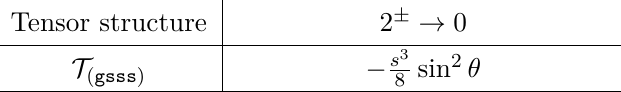
Table 8 . Angular distributions for the gsss tensor